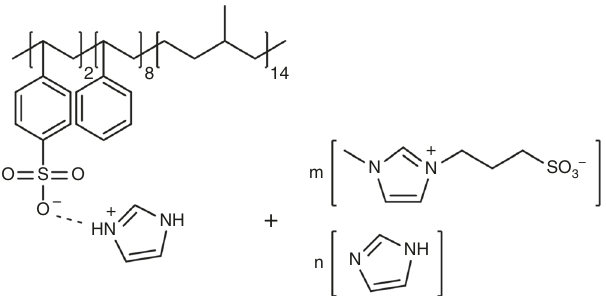
Fig. 1 Molecular structures. Molecular structures of PSS:Im- b -PMB samples containing different molar ratios of ZImS:Im (1:0, 1:1, and 2:1 per mole of – -Im + moieties in the – SO 3